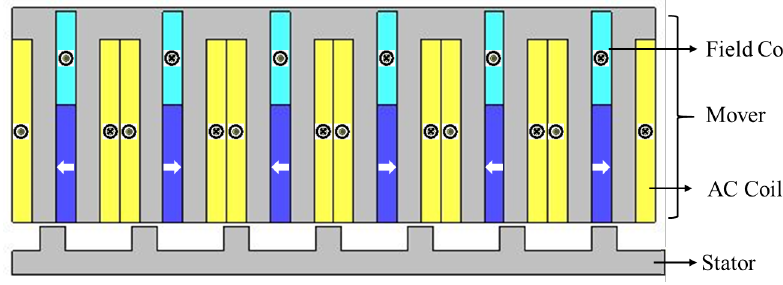
Figure 1. Design of proposed single-sided VFPMLM.